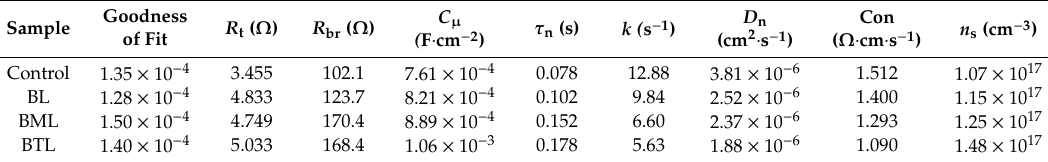
Electrochemical properties of DSSC fabricated without (control sample) and with nanocrystalline TiO 2